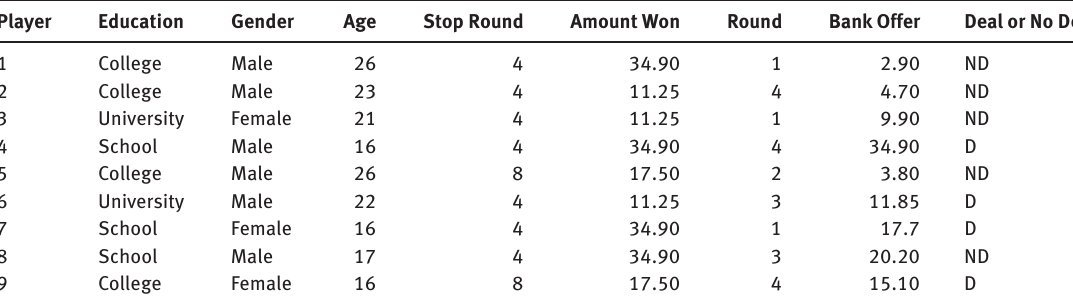
Table 3: Part of the Training Dataset Used in Determining the Center of Cluster and Procedural Knowledge. Player